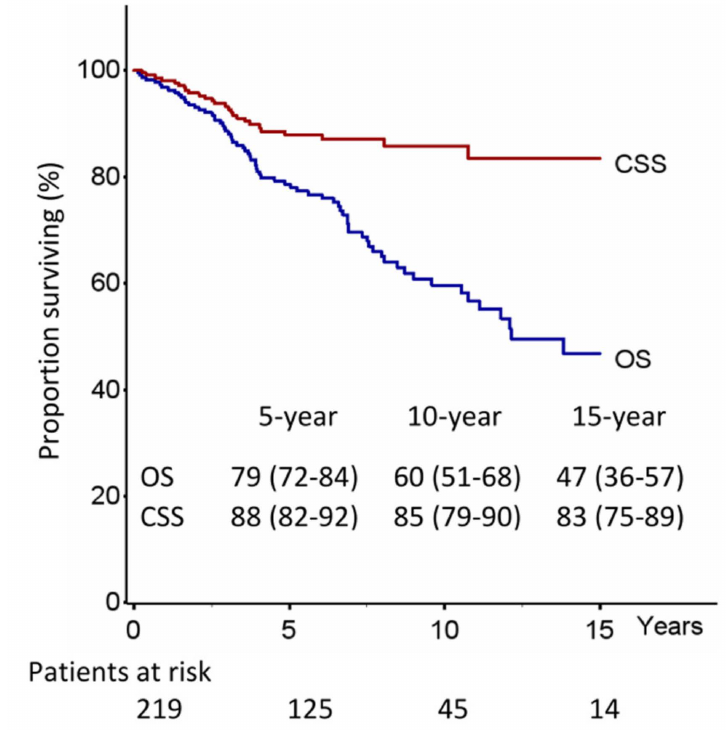
Figure 1. Overall survival (OS) and lung cancer specific survival (CSS). Whereas OS was significantly related to age ( p < 0.001) and to cardiovascular comor- bidities ( p = 0.04), the number of lymph nodes removed was an independent prognostic factor of CSS ( p = 0.02) (Figure 2 and Table